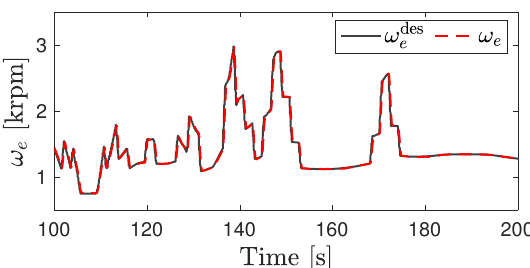
Figure 16. Engine speed and its desired value for the hardware-in-the-loop experiments during t = 130 s to t = 190